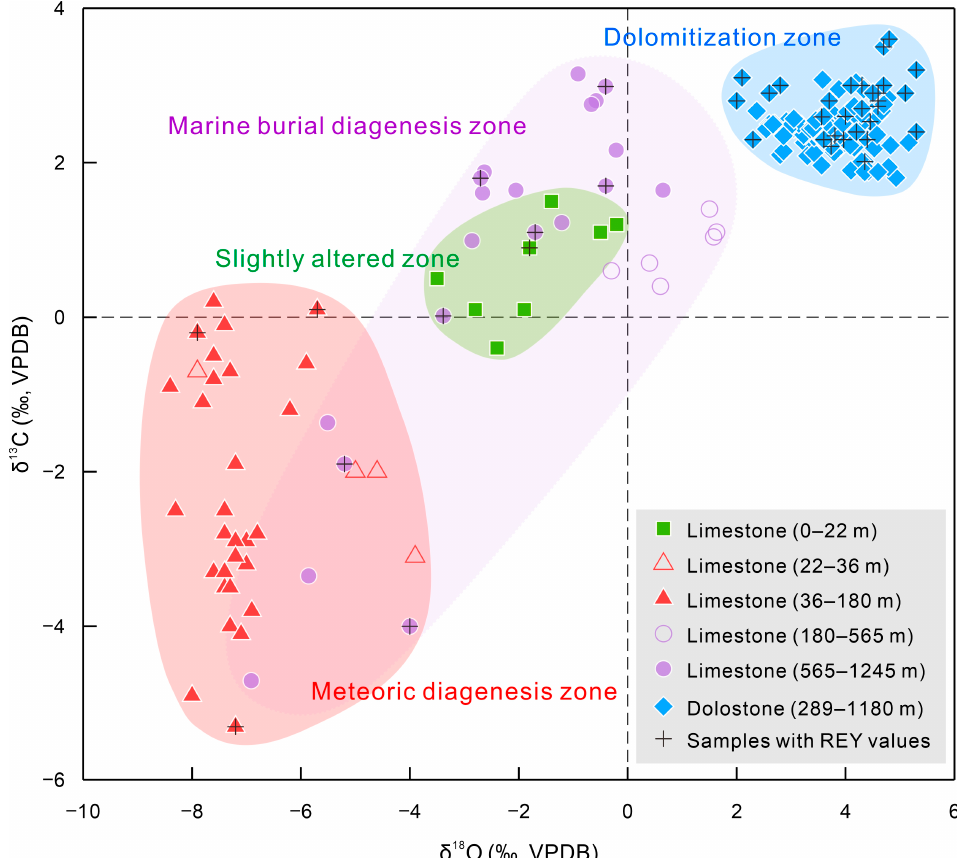
Figure 4. Cross plot of δ 13 C and δ 18 O values of the XK-1 core carbonates in different diagenesis zones. Diagenesis types, including meteoric diagenesis, marine burial diagenesis and dolomitization, are identified based on the petrographic features, mineralogical composition, and δ 13 C and δ 18 O values. δ 13 C and δ 18 O data on the VPDB scale are from [44–46]. The hollow symbols correspond to samples identified as experiencing weak diagenesis. The black cross symbols (+) represent samples with measured REY concentrations in this paper. Numbers in parentheses represent depth.